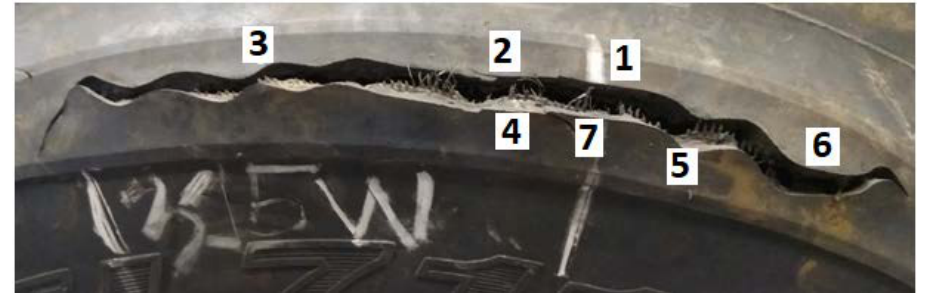
Figure 13. Places of sampling and method of marking samples.